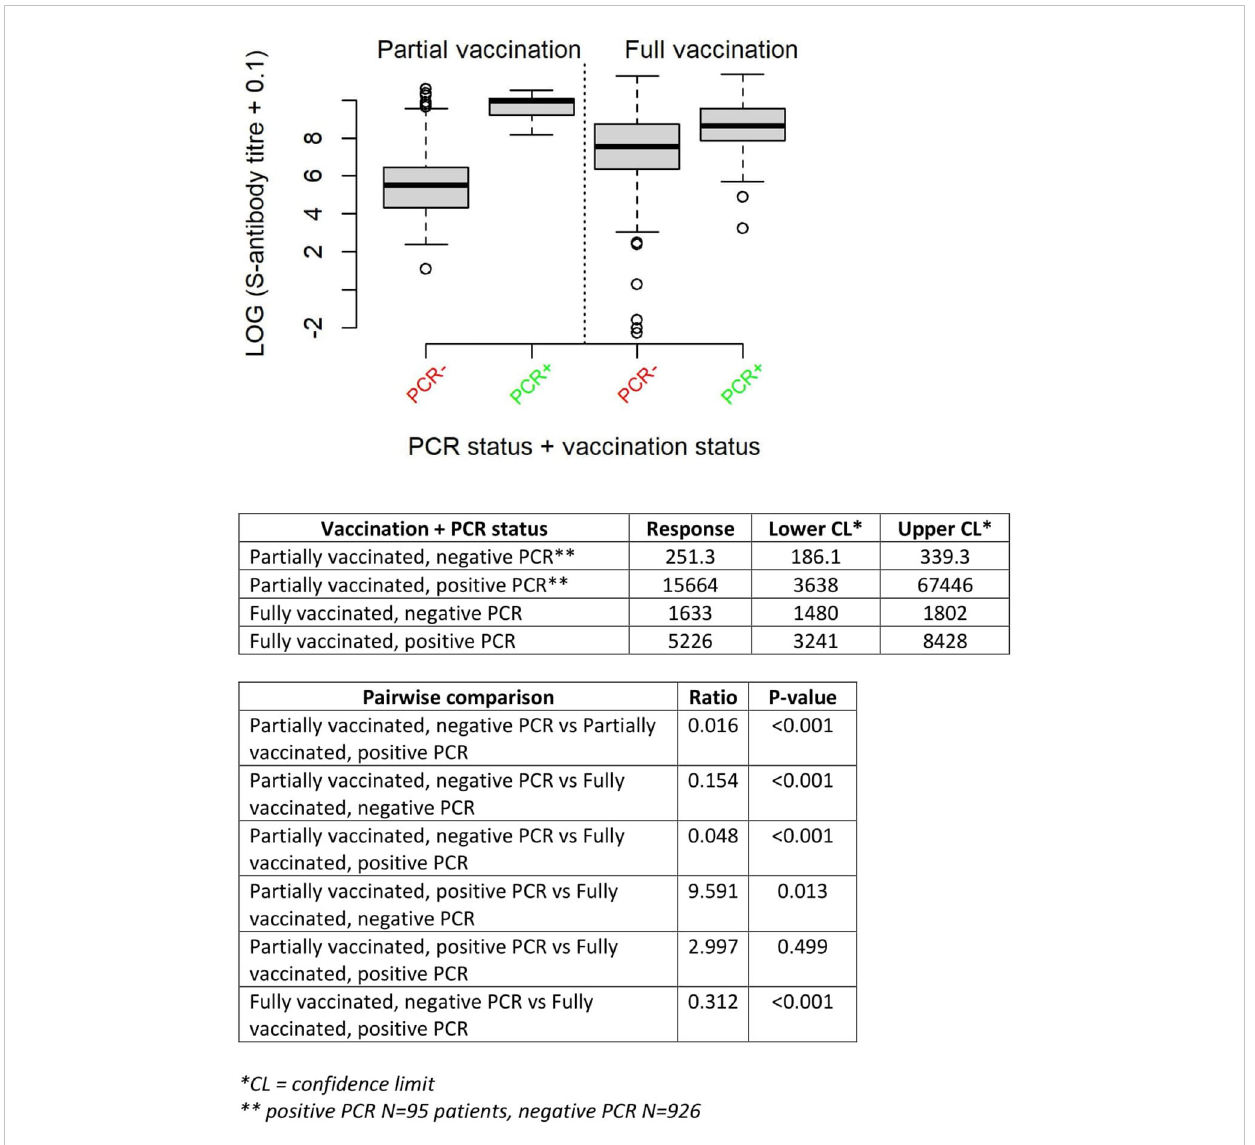
FIGURE 3 Anti-S-antibody titre (log-transformed) according to vaccination and PCR